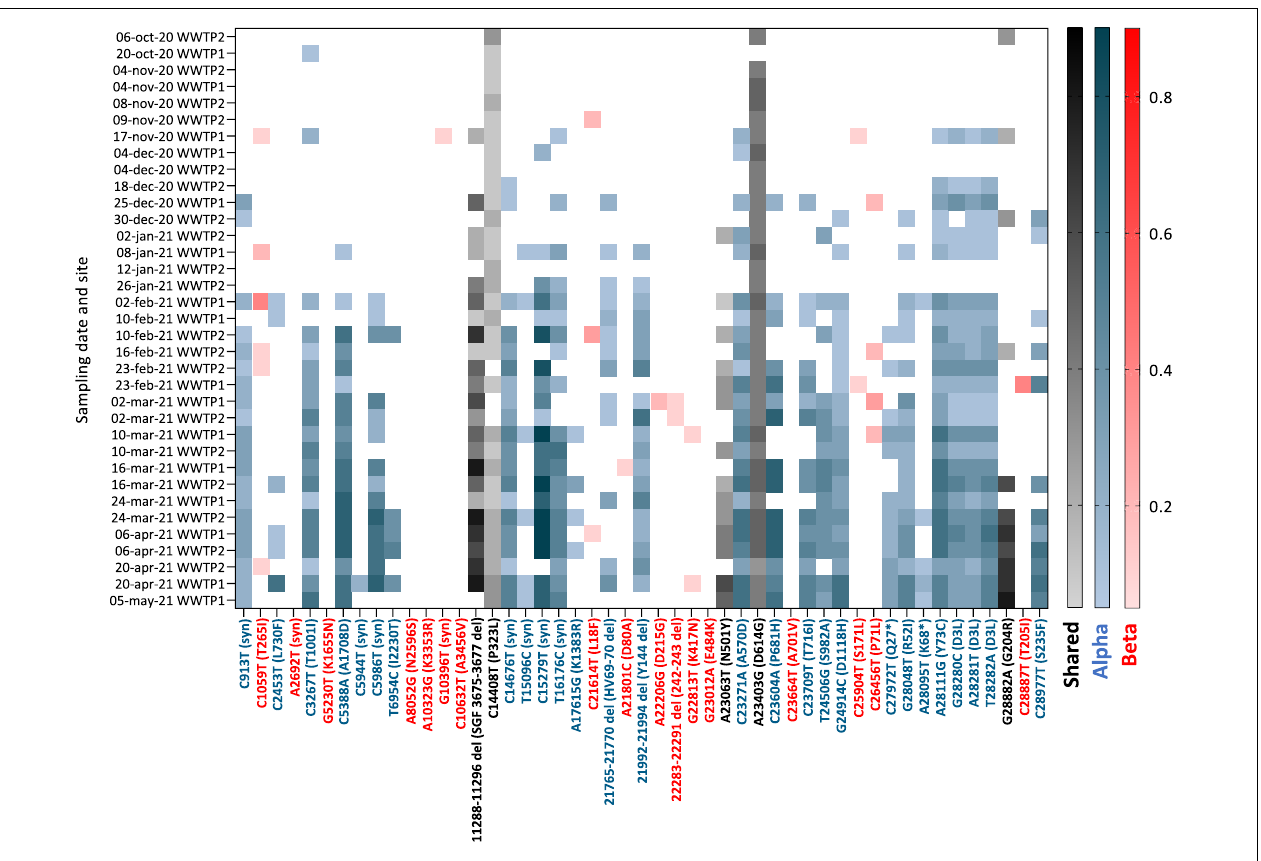
FIGURE 5 | Heatmap of the frequency (color shades) of VOC signature mutations ( x axis) in raw wastewater samples collected in 2 WWTP from Nantes overtime ( y axis). Blue: Alpha VOC, red: Beta VOC and black: shared mutations. White indicates that no mutation was detected after applying quality filtering and detection